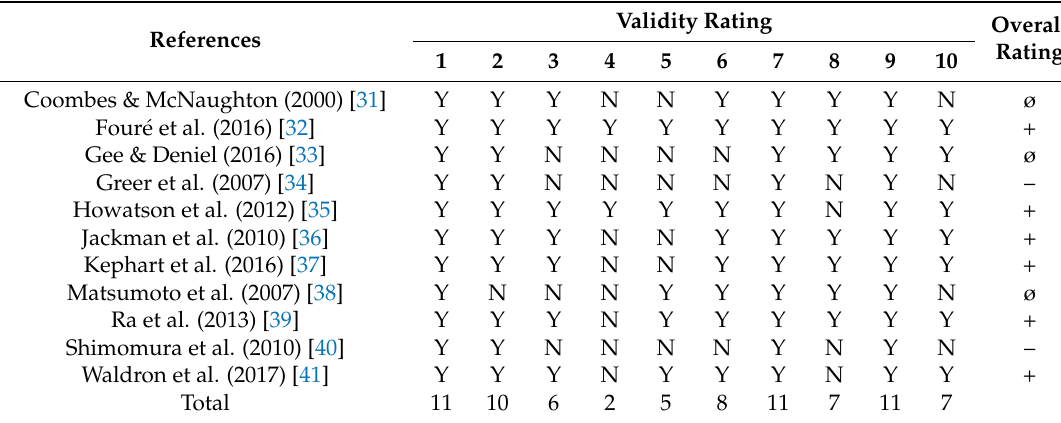
Table 3. Quality assessment of included studies.